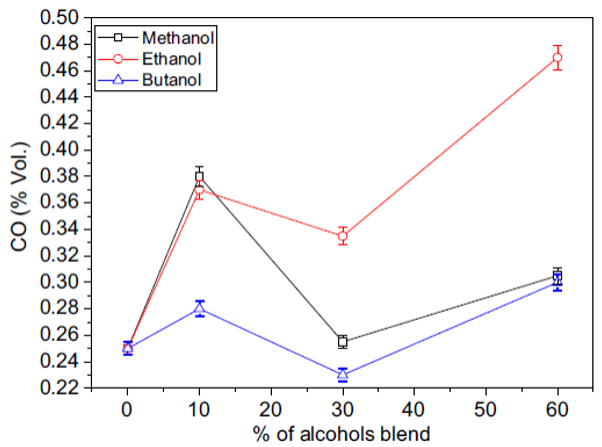
Figure 7. Variation in CO emissions with alcohol content in the blends at 3 bar BMEP and equivalence ratio ϕ = 1: comparison between methanol, ethanol and butanol [95]. Reproduced with permission from Applied Thermal Engineering; published by Elsevier, 2017. License Number: 5094081168292.